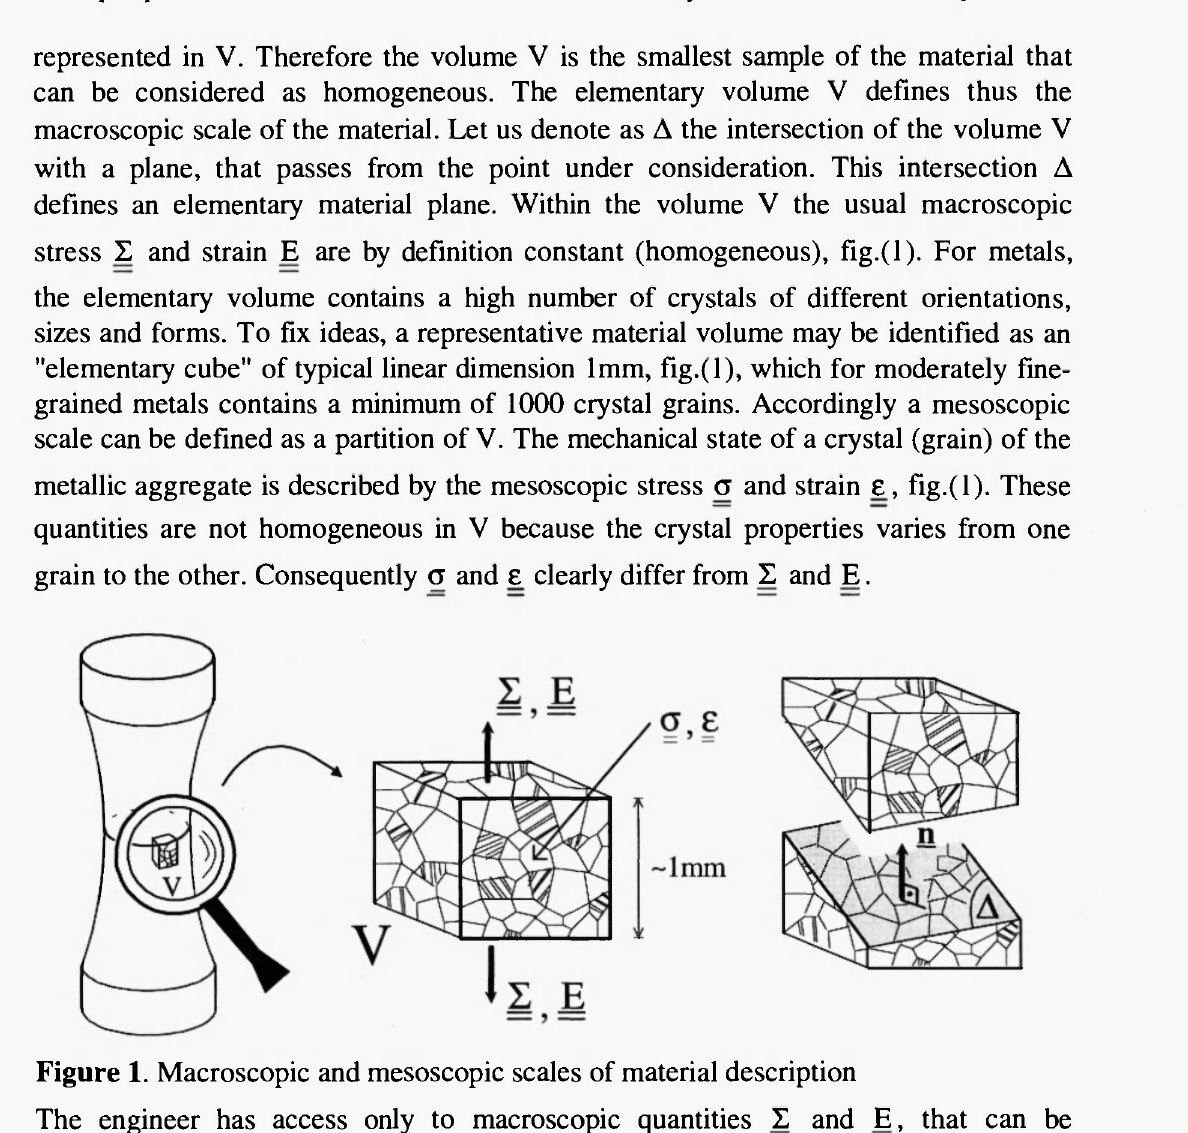
Figure 1. Macroscopic and mesoscopic scales of material